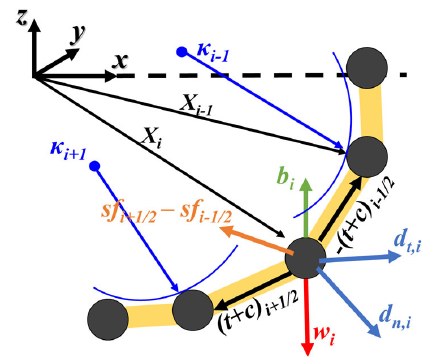
Figure 9. Schematic diagram of internal and external force.